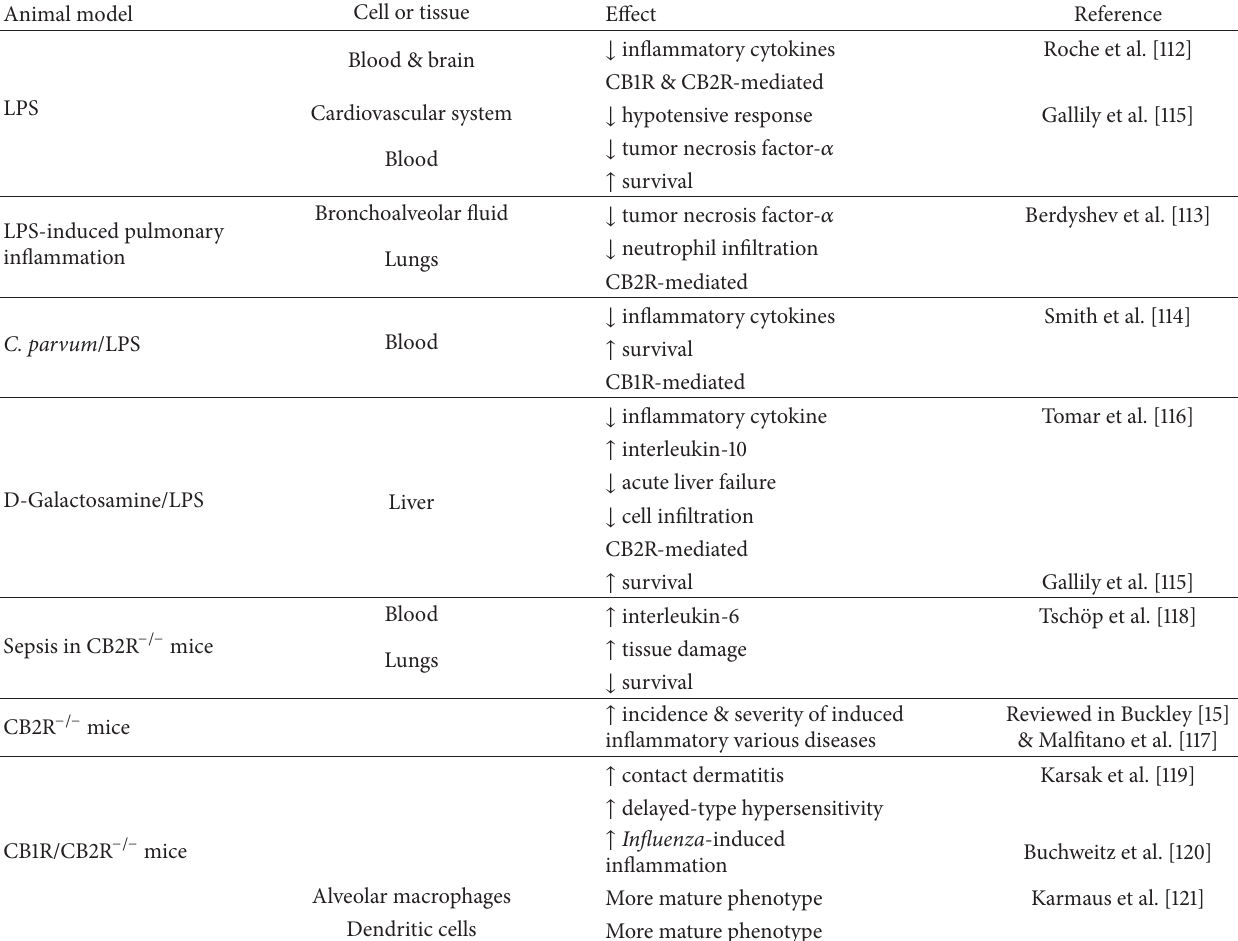
Table 2: Cannabinoid effects on in vivo TLR